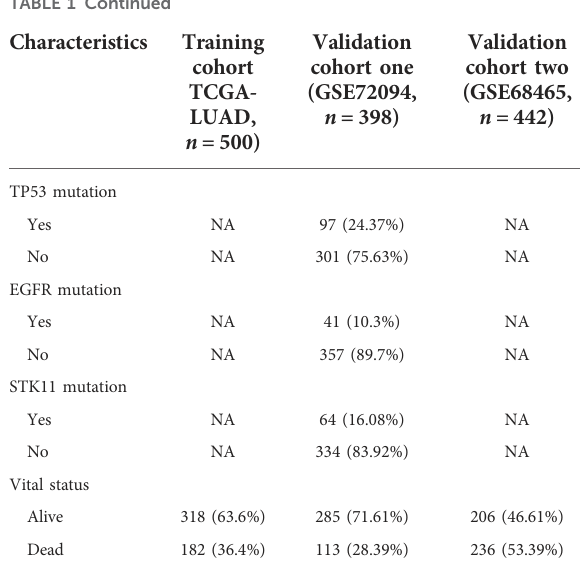
TABLE 1 Clinical characteristics of patients involved in the